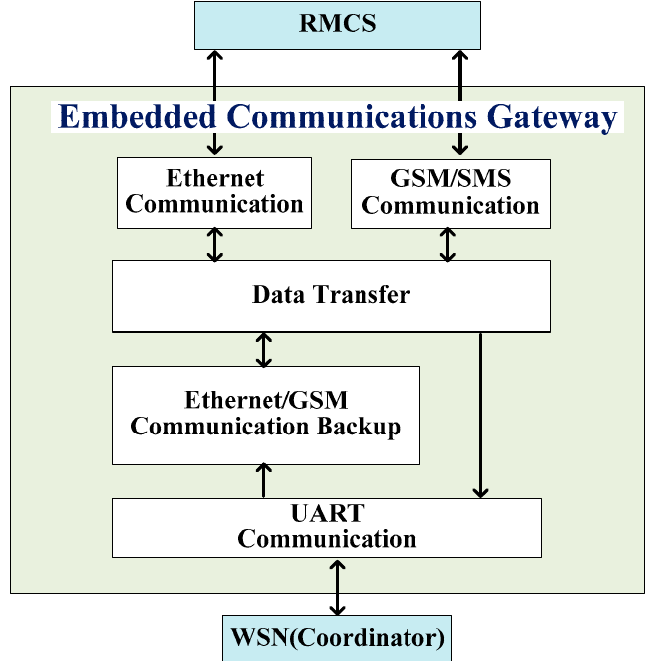
Figure 3. Functional design of embedded communication gateway with automatic back-up capabilities.